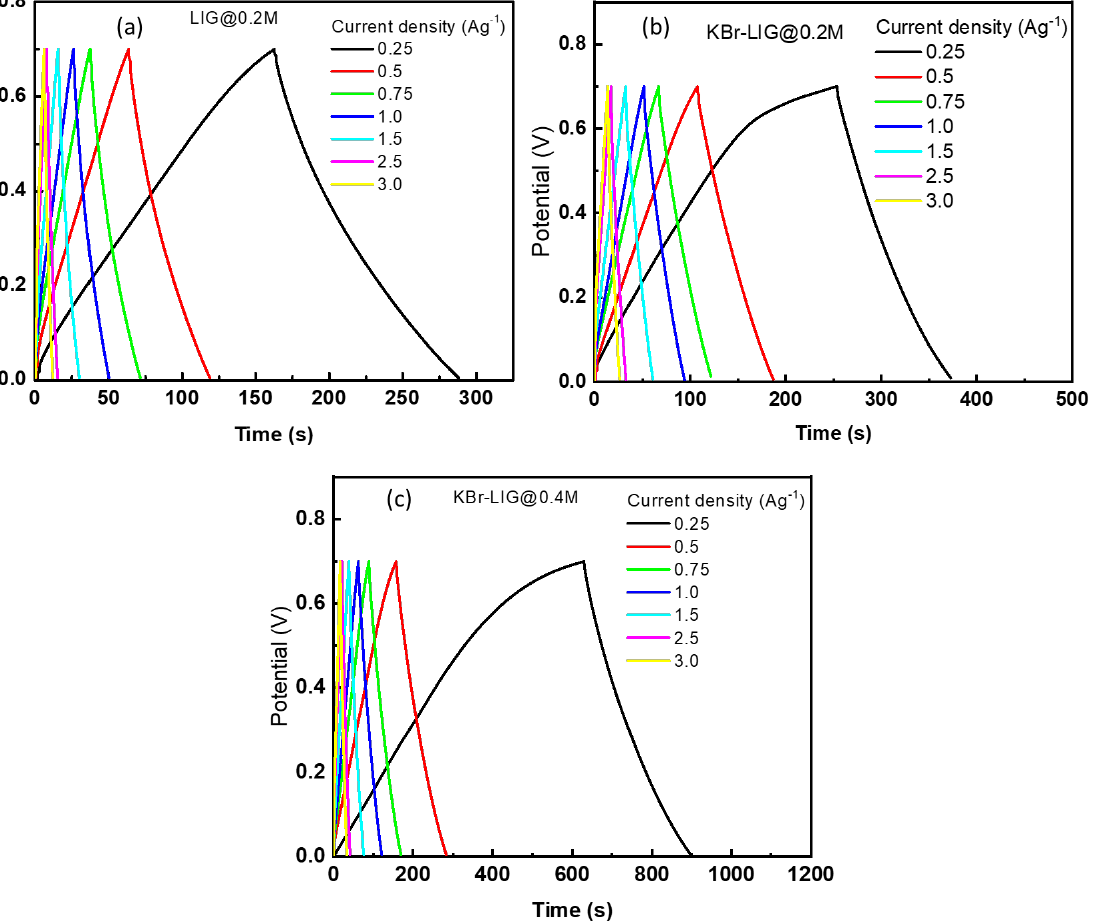
Figure 5. Galvanostatic charging-discharging curves as a function of time measured at various current densities for ( a ) LIG@0.2M, ( b ) KBr-LIG@0.2M, and ( c ) KBr-LIG@0.4M.